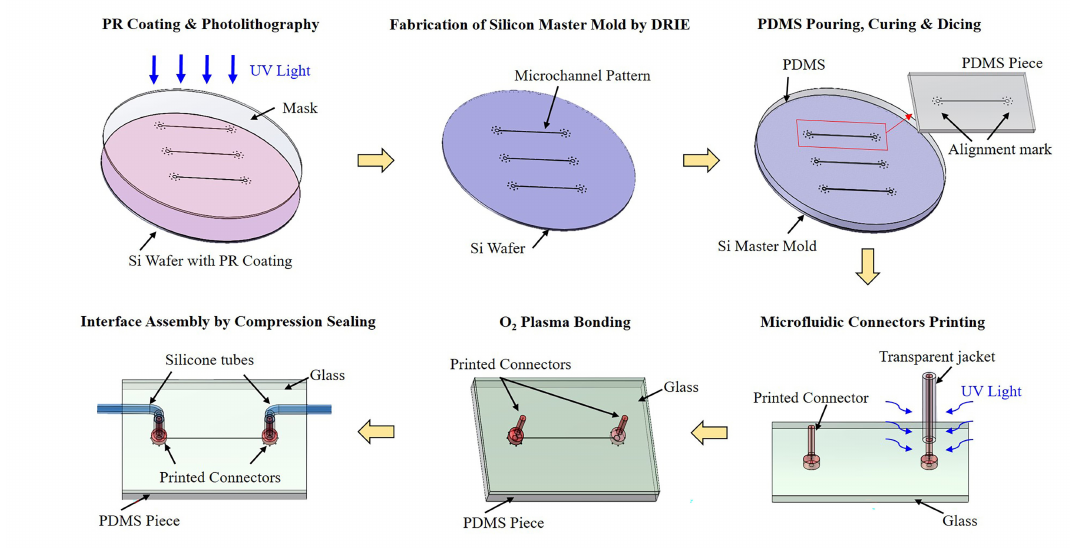
Figure 3. Fabrication process of a typical PDMS–Glass microfluidic device with printed